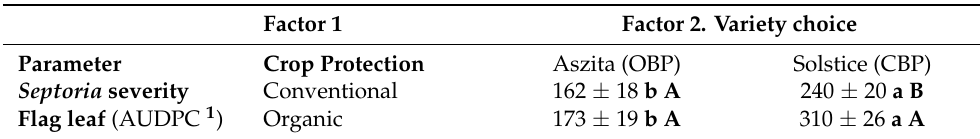
Table 4. Interaction means ± SE for the effects of crop protection and variety on Septoria severity in